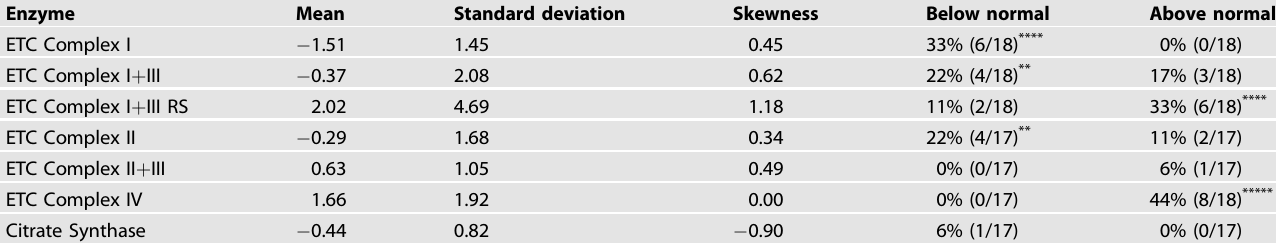
Values in bold, underline and italic are outside the normal range. Since these are normalized values, they are in standard deviation units. ** p < = 0.001; *** p < = 0.0001; **** p < = 0.00001; ***** p < = 0.000001. Table 4 outlines the number of cases outside the normative range as well as the signi fi cance of this number as calculated using a Binomial distribution. Three ETC Complexes had more cases below the normal range than would be expected by chance. ETC Complex I demonstrated below normal activity in 33% of the ASD participants while ETC Complex I + III and II demonstrated below normal activity in 22% of the ASD participants. Two ETC Complex demonstrated more cases above the normal range than would be expected by chance. ETC Complex I + III RS demon- strated above normal activity in 33% of the ASD participants while ETC Complex IV demonstrated above normal activity in 44% of the ASD participants.